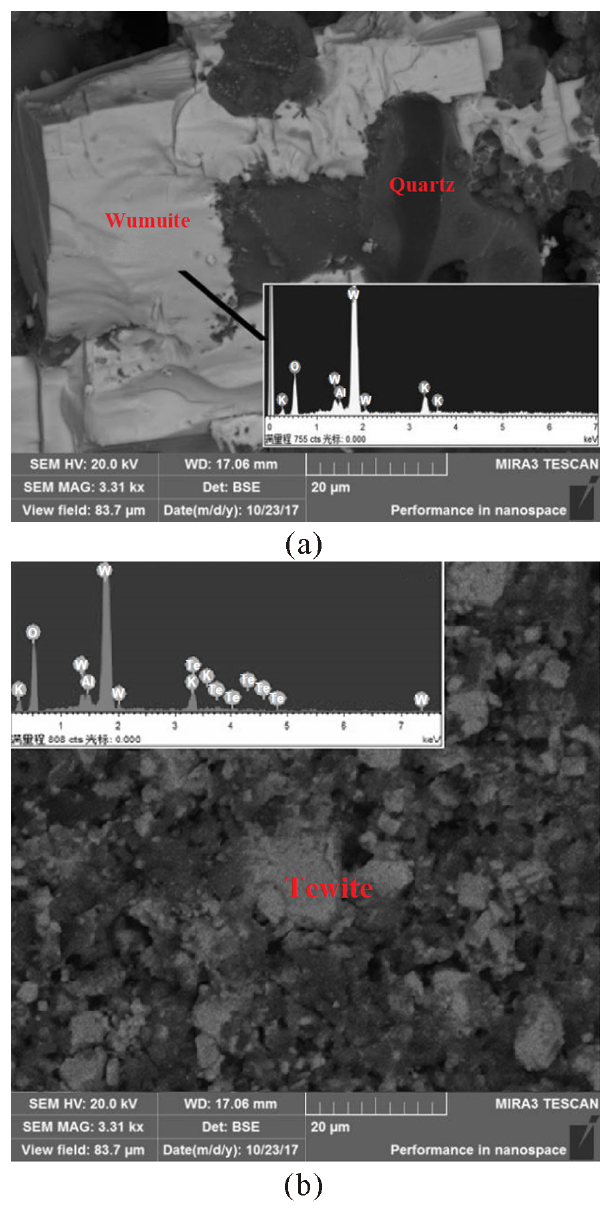
Figure 9. The BSE images of the products of the artificial synthetic experiments. (a) Wumuite was synthesized from WO 3 and natural potassium feldspar; (b) tewite was synthesized from WO 3 , TeO 2 , and the synthetic